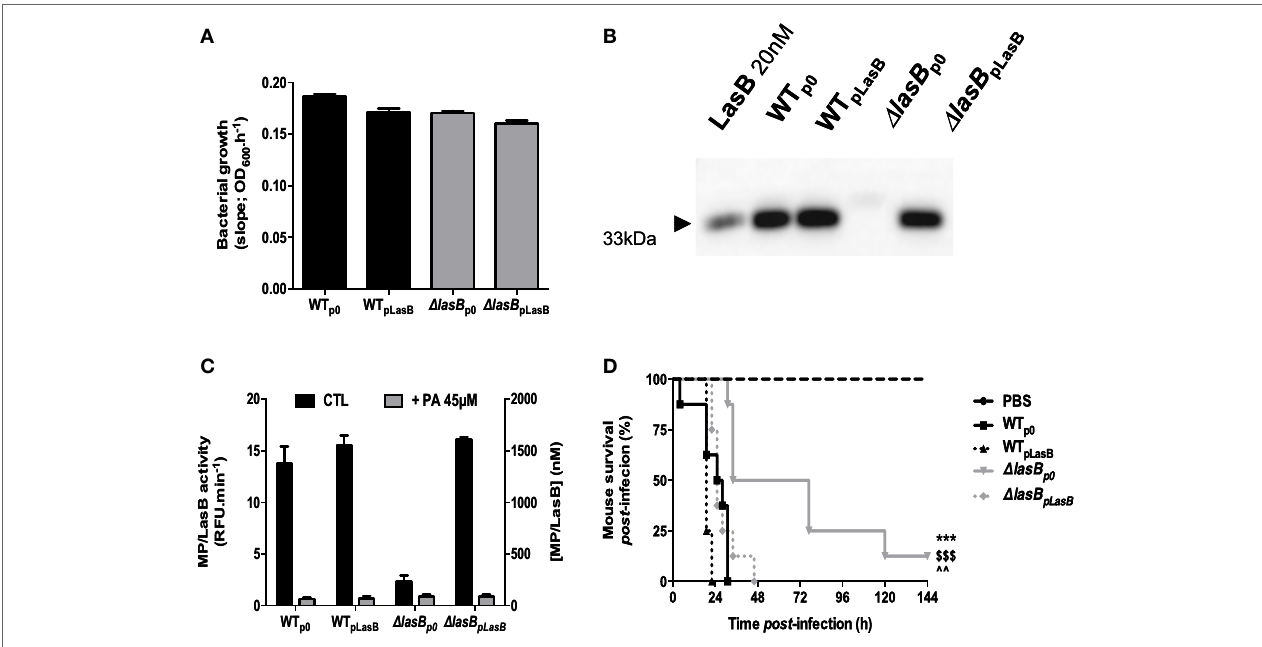
FigUre 1 | Characterisation of bacterial strains and mice survival. (a) The growth of WT − , WT + pLasB − , Δ LasB − , Δ LasB + pLasB-PAO1 was evaluated by measuring the absorbance at 600 nm of overnight bacterial culture supernatants. Results are expressed as means ± SD. (B) The presence of LasB in these cultures was confirmed by Western Blot analysis with anti-LasB immun-serum (see Materials and Methods). (c) The enzymatic activity of LasB in these cultures was measured using TACE substrate II, a fluorogenic substrate (dark bars), and the specificity of this activity was verified using phosphoramidon (PA), a metalloprotease inhibitor (gray bars, see Materials and Methods). Results are expressed as means ± SD. (D) C57/Bl6 mice were infected intra-nasally (i.n) with PBS ( n = 4) or 10 9 cfu of Pseudomonas aeruginosa bacterial strains (see above, n = 8 for each bacterial strain) and mouse survival was followed over time. *** p < 0.001, compared to WT-PAO1; $$$ p < 0.001, compared to WTplasB; ^^ p < 0.01, compared to Δ